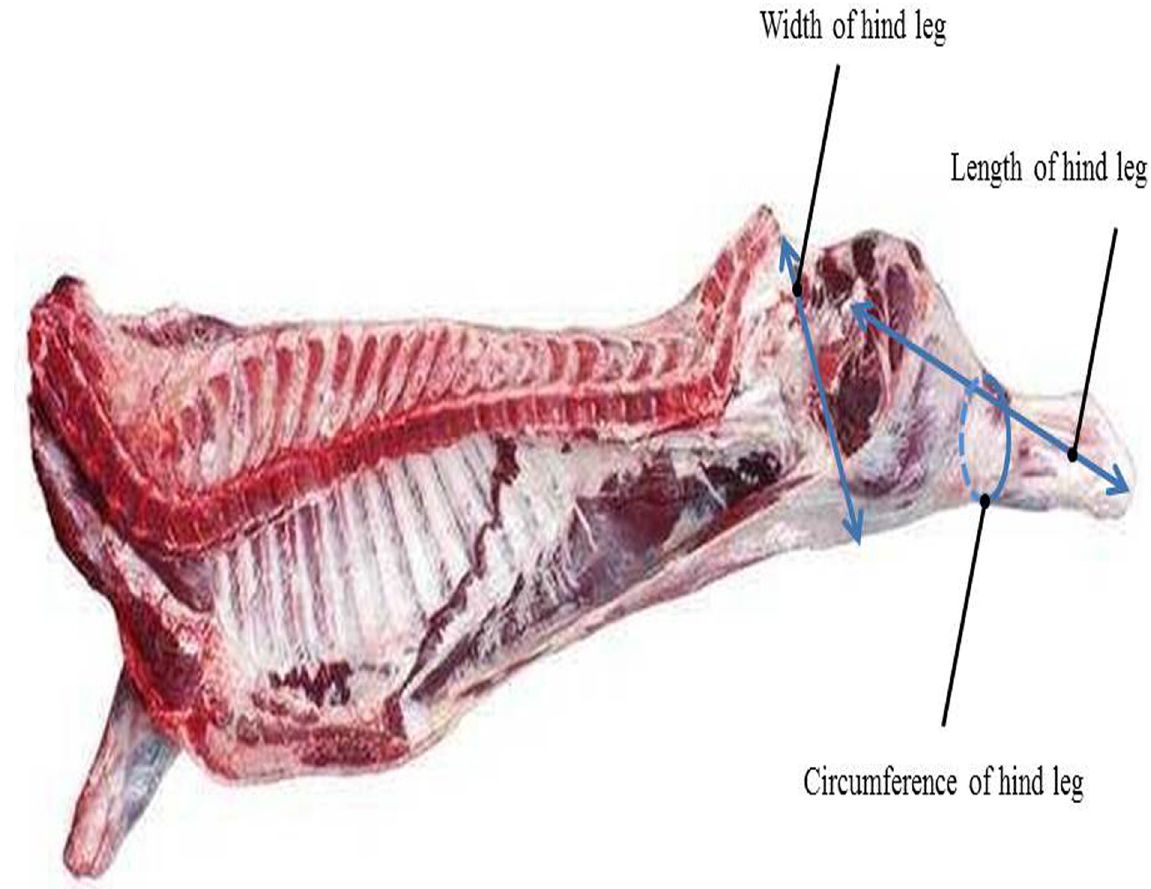
Fig 1. Locations of width, length, and circumference of hind leg measurements for the experimental beef carcasses.